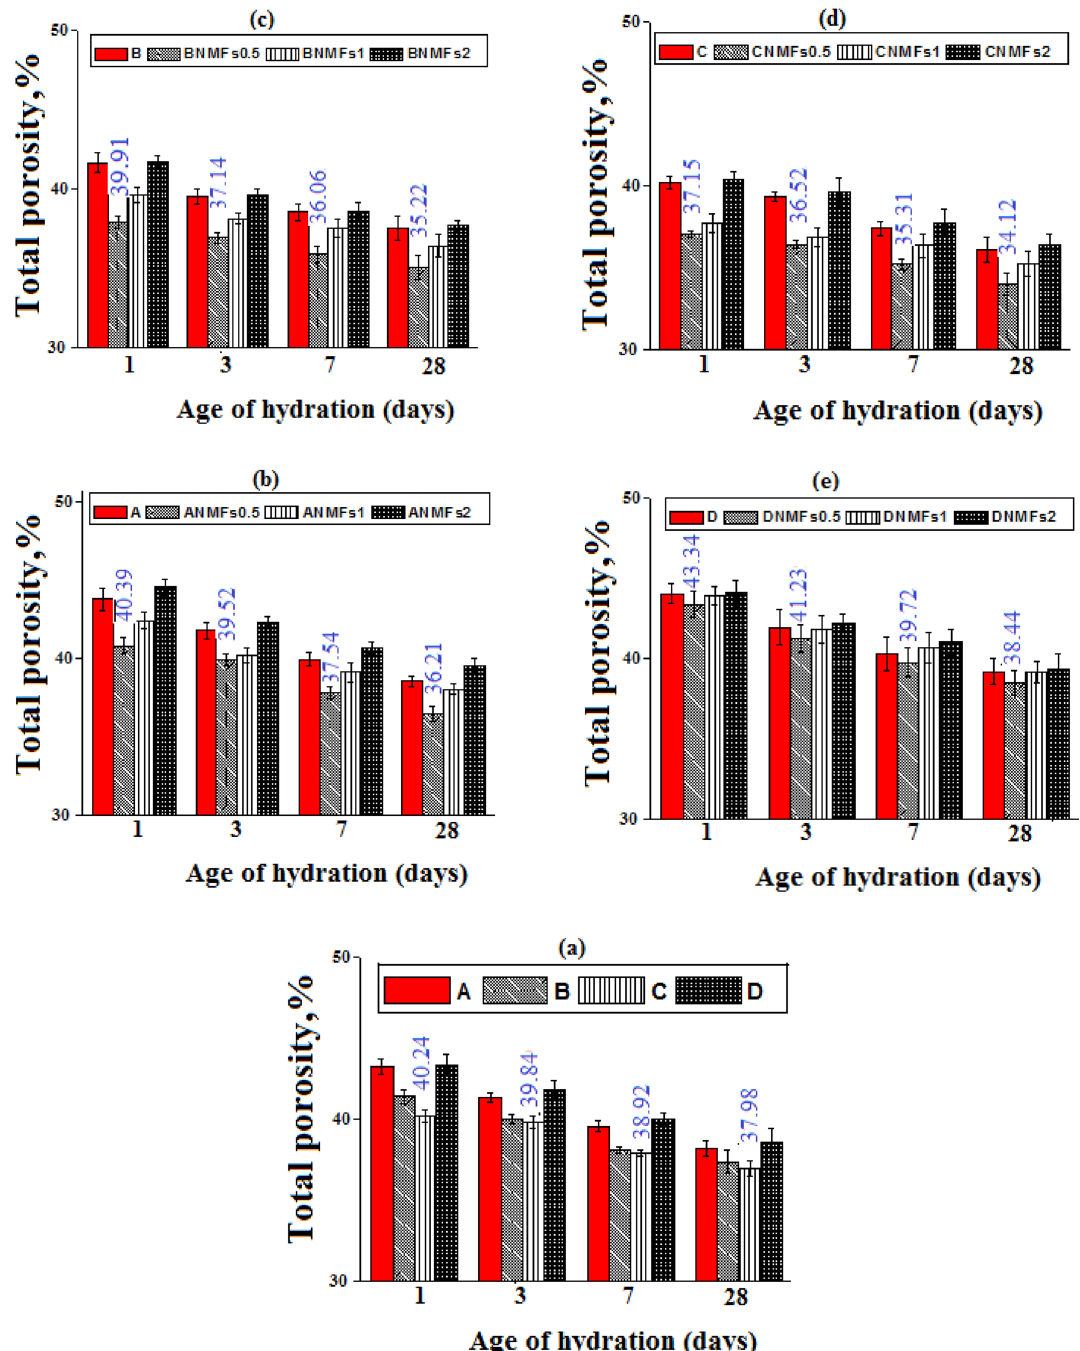
Figure 9. Total porosity values of different hardened the magnetic nature of ferromagnetic spinel nanoparticles that leads to magnetostatic interactions between the particles, promoting the production of harden matrix possess high resistance to fire deterioration 46 . Figure 12a–d. display the RS (%) values for different composites after rapid cooling (cooling in water) after firing at 300, 600, and 800 °C for 180 min. All composites undergo a continuous loss in strength upon being cooled in water after heating at different reported temperatures (300–800 °C), and the degree of loss in strength increases with temperature, Fig. 12a–d. Clearly, the degree of depletion in strength is higher (RS% lower) for all composites as compared to their loss when undergoing slow cooling after treatment at the same temperature. The intensive reduction in compressive strength for the rapidly cooled samples values is ascribed to the thermal shock to occur by the sudden cooling of fired specimens that causes the creation of several cracks as well as enlarges of the microcracks present along the composite matrix 34 . As previously mentioned in many studies using nanofiber/tubes as nano montmorillonite (NM) and carbon nanotubes (CNTs), Titania nanoparticles